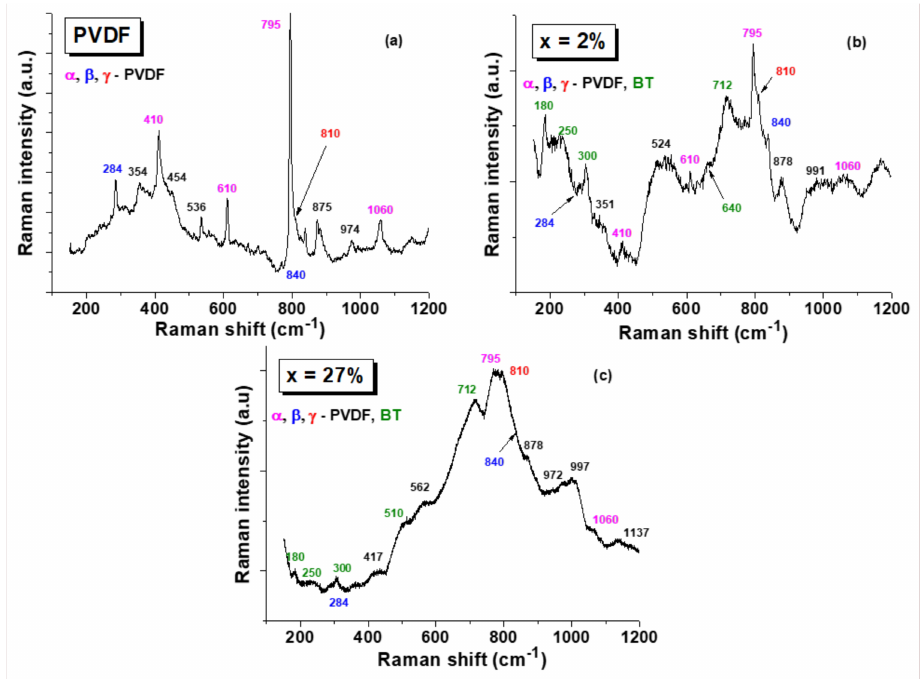
Figure 5. Room temperature Raman spectra of PVDF thick film ( a ) and of 20%( x Ag − (1 − x )BT) − 80%PVDF composites with x = 2% ( b ) and x = 27% ( c ) in the frequency range of 100 cm − 1 to 1200 cm − 1